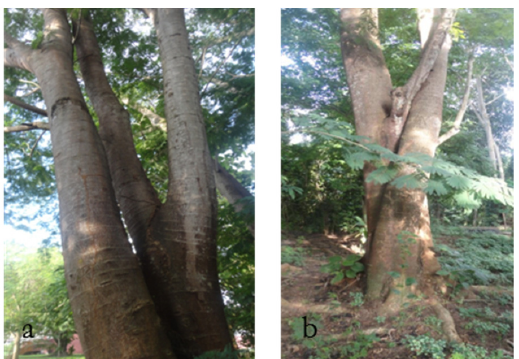
Figure 1. Habit of Enterolobium cyclocarpum tree